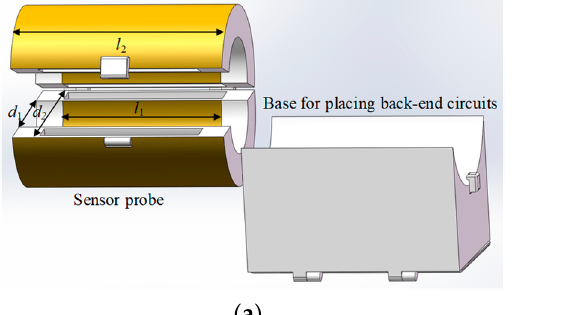
Figure 4. ( a ) Schematic diagram of coaxial induction probe. ( b ) Analysis of the influence of l 2 / l 1 on shielding effect.